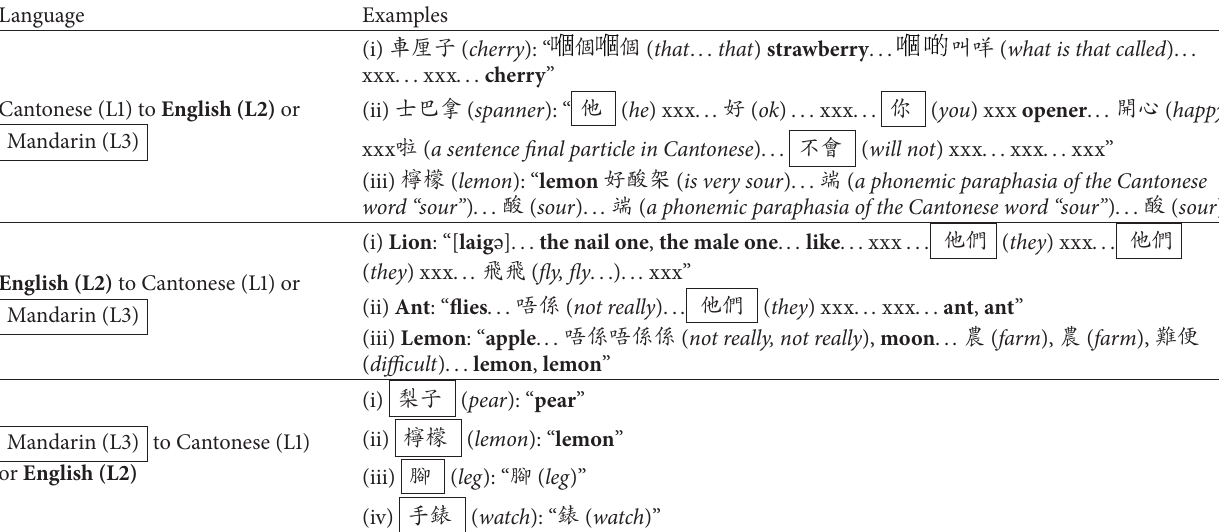
Table 2: Samples of Dr. T’s code switching at the single-word level (confrontation